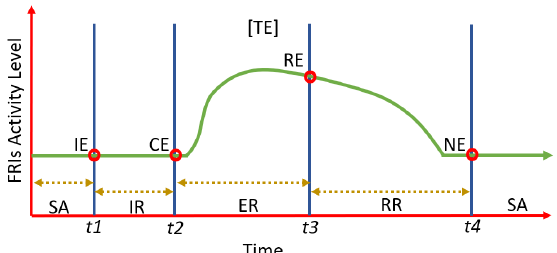
Figure 1. Representation of the First Response Institution (FRI) activity level along time when an emergency is detected. Activity level has four phases (Situational Analysis (SA), Initiation Response (IR), Emergency Response (ER), Restoration Response (RR)) and five decision points (Initiating Event (IE), Control Event (CE), Restoration Event (RE), Normalizing Event (NE), Termination Event (TE))